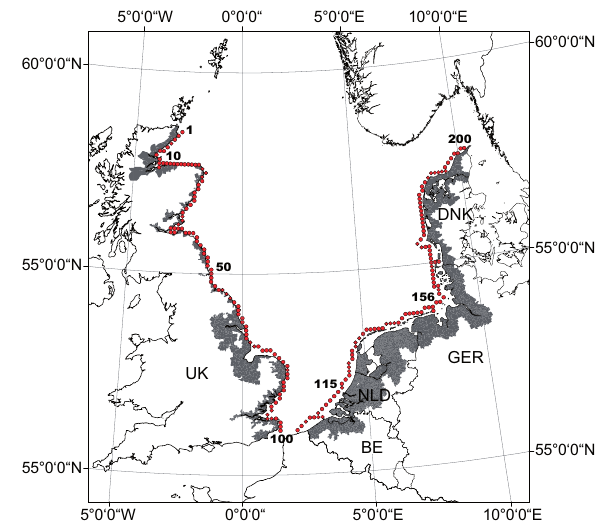
Fig. 1. Model area for storm surge models. Points 1-200 follow the 10 m depth contour line. Shading indicates postal code areas with land elevation < 10 m. Table 1. Data sources for the coastal protection Country Authority or reference document